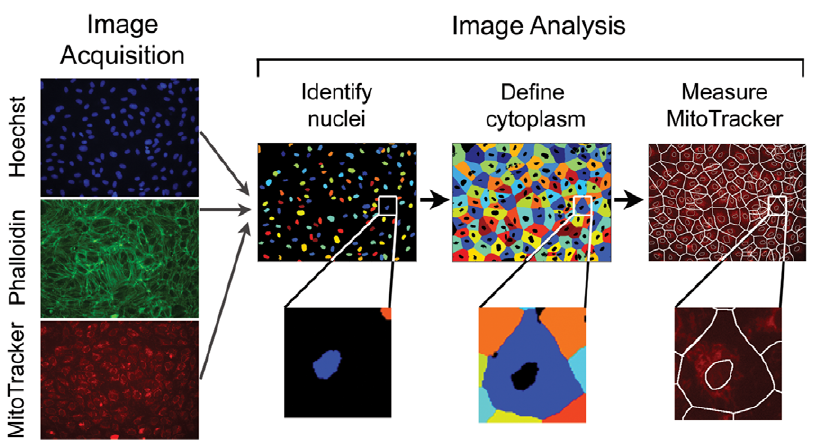
Figure 1. An image-based assay for mitochondrial content and cell size.